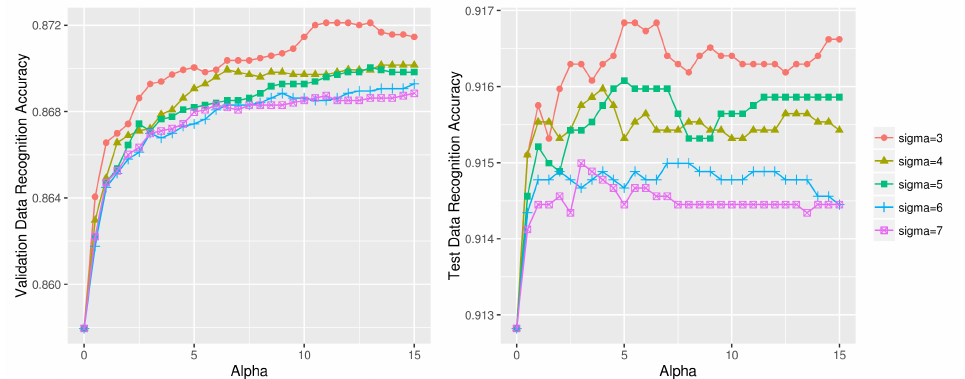
Figure 12. Stand vs. walk recognition accuracy using different ( σ , α ) combinations on lower body OPPORTUNITY dataset ( left : validation data, right : test data).